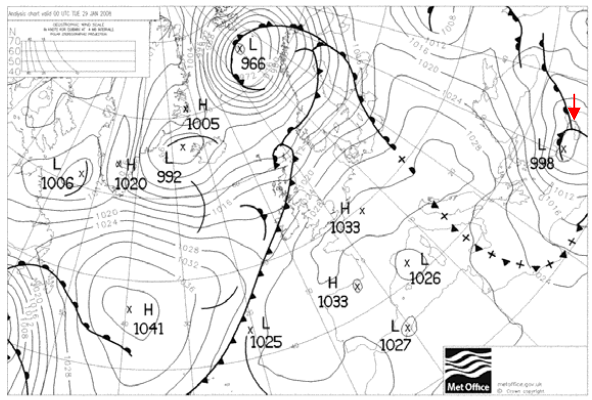
Fig. 2. Surface analysis chart for 0000 UTC 29 January 2008 (U.K., Met. Office). The red arrow points to Cyprus area.